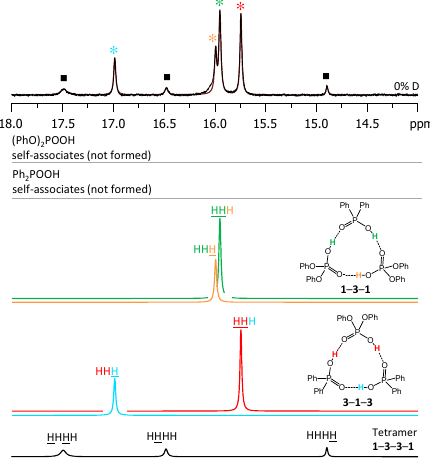
Figure 4. The parts of 31 P - NMR spectrum of the sample containing acids 1 and 2 (1:1) in CDF 3 /CDF 2 Cl at 100 K. The experimental spectrum is deconvoluted into the sub-spectra arising from self-associated of 1 or 2 , heterodimer 1 - 2, and two heterotrimers, 1 - 2 - 1 and 2 - 1 - 2 . For visual clarify the signals in the experimental spectrum and the computed sub-spectra are color coded. Trimers and dimers are marked by asterisks and diamonds, respectively.